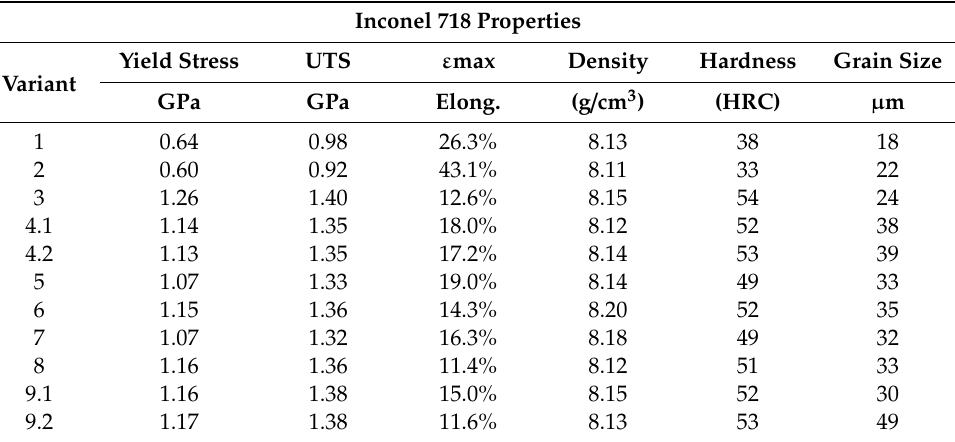
Table 2. Mechanical Properties and Related